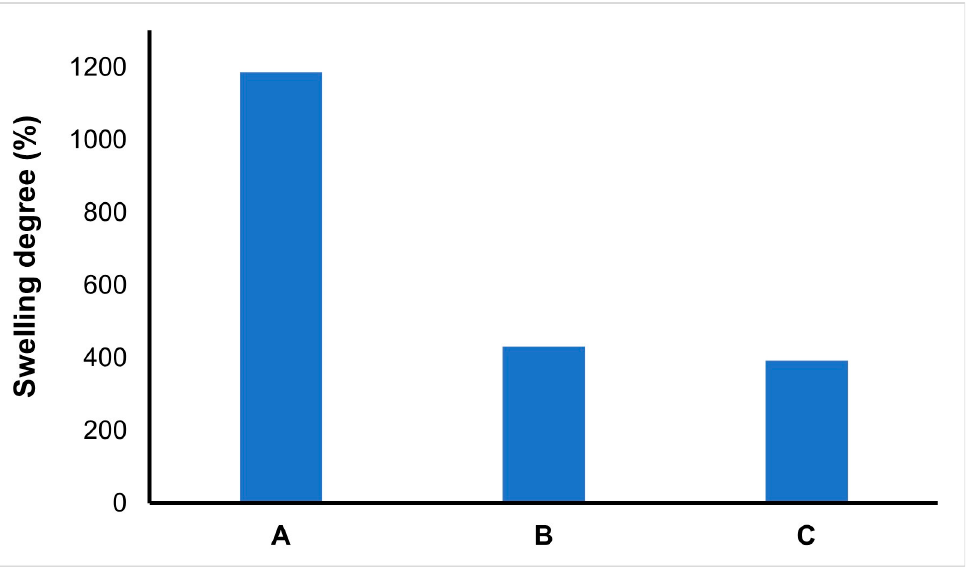
Figure 4. % Swelling degree. ( A ) BC-NFs; ( B ) NIP/BC-NFs; ( C ) E2-NP/BC-NFs.